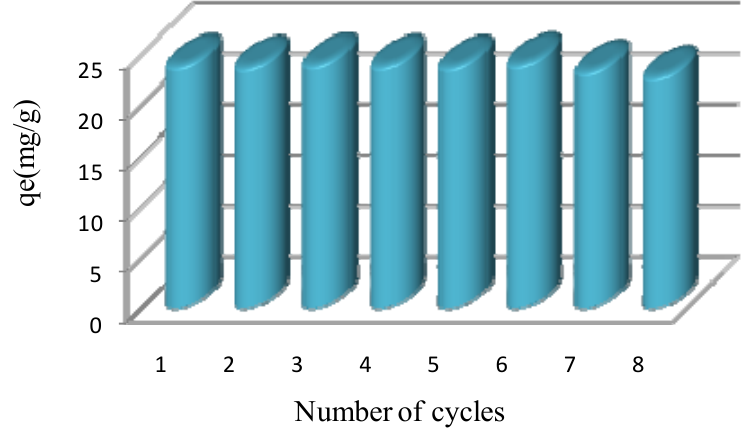
Figure 10. Recycling of the IIP/Mt in the removal of Cu 2+ from aqueous relations ( C 0 = 20 mg/L, pH = 5, RT).